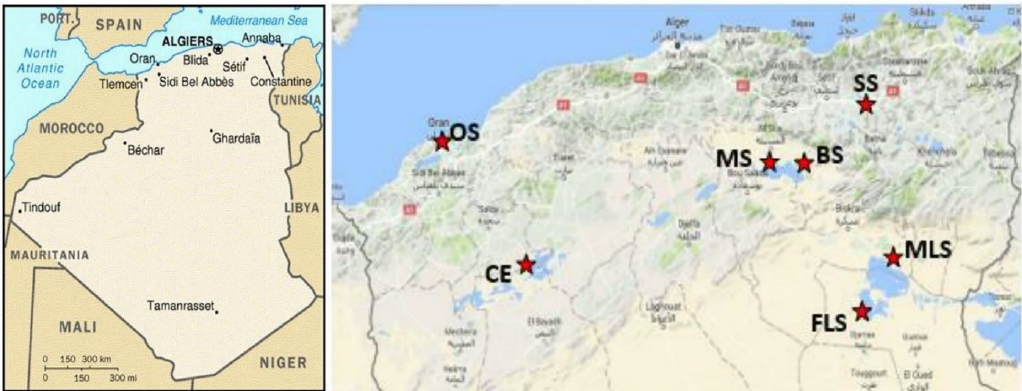
Figure 1. Map of sampling locations. SS, Soukhna sebkhet; BS, Baniou sebkhet; MS, Mcif sebkhet; OS, Oran sebkhet; MLS, Melghir sebkhet; FLS: Felghir sebkhet; CE, Chott Echerguie.